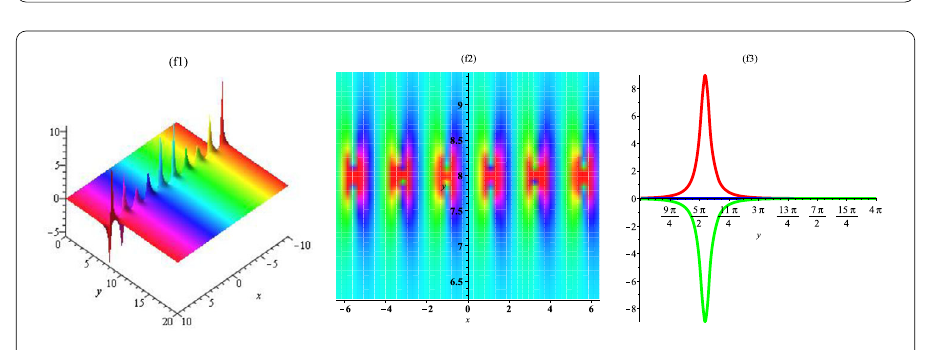
Figure 9 For solution of (3) u , v , w , c i = 1, t = 1, z = 10, (f1) 3D plot (f2) density plot and (f3) 2D plot with spaces x = –3,0,3